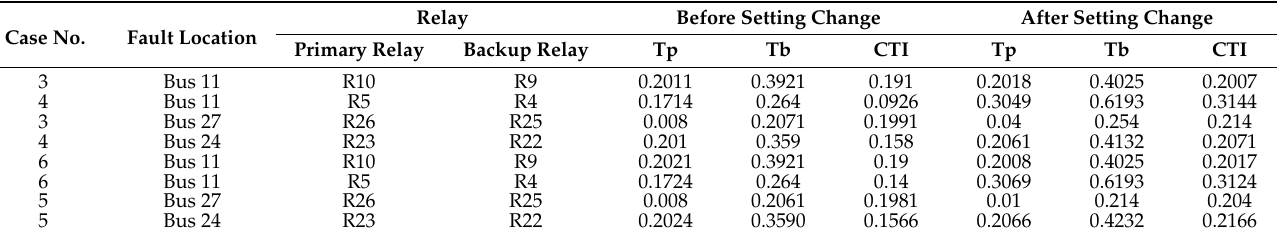
Table 6. Validation of the hybrid protection scheme